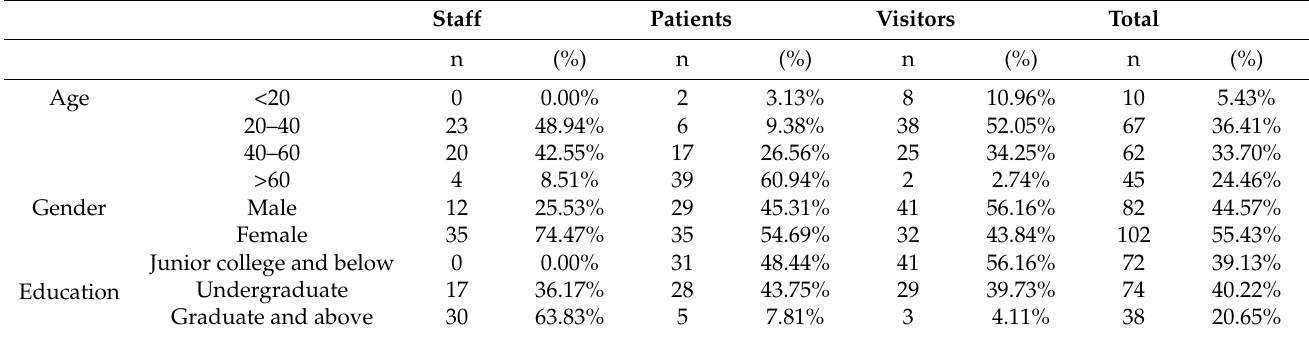
Table 3. Survey demographic information.